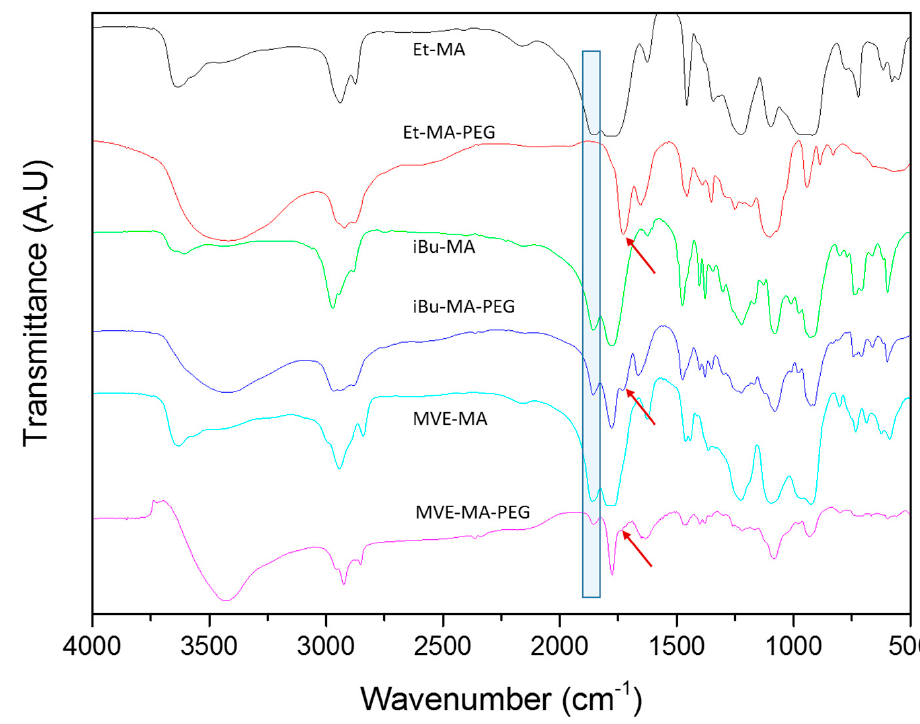
Figure 2. FTIR spectra of the pristine copolymers and prepared hydrogels.